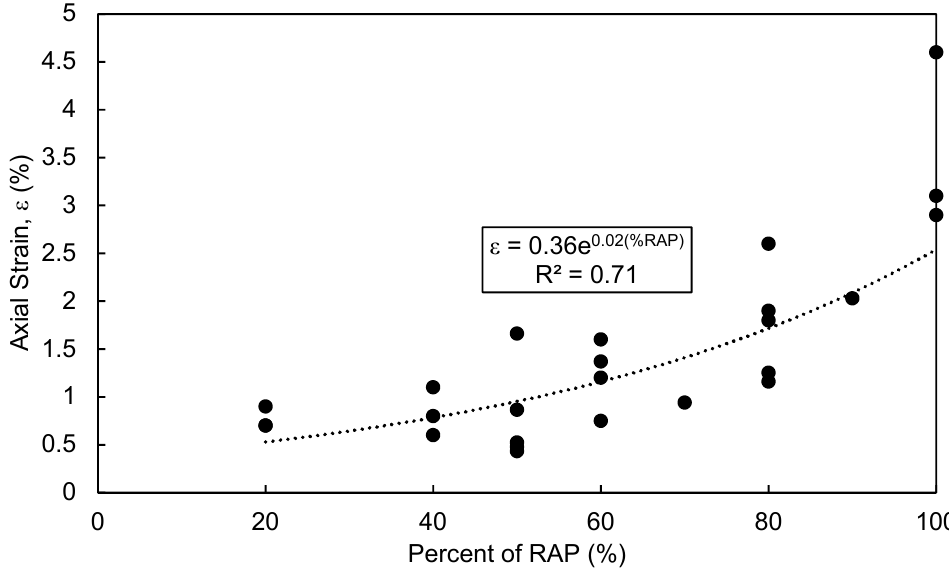
Figure 8. Percent of RAP in RAP-aggregate mixtures versus the maximum axial strain achieved at the conclusion of creep testing [13,17,18].